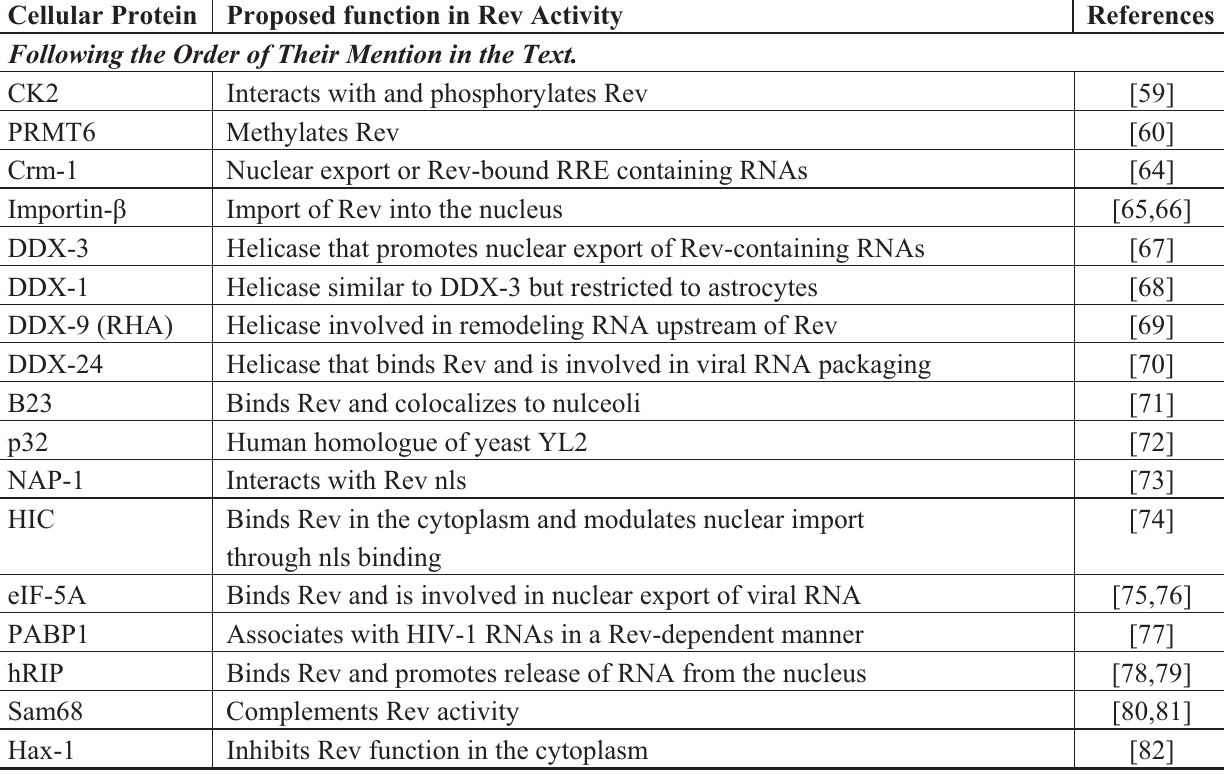
Table 1. Cellular cofactors that modulate Rev